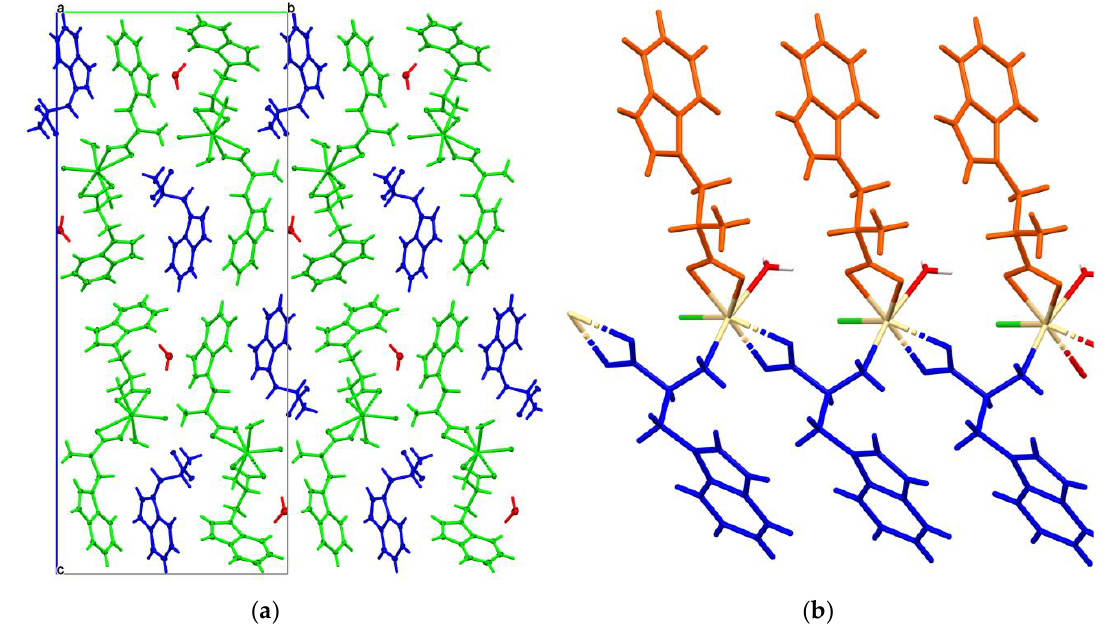
Figure 3. ( a ) Packing of the molecules into the crystal of the compound along the a axis; ( b ) the coordination polymer main chain created along the a direction (the zwitterion molecule was marked in orange and the anion in blue).